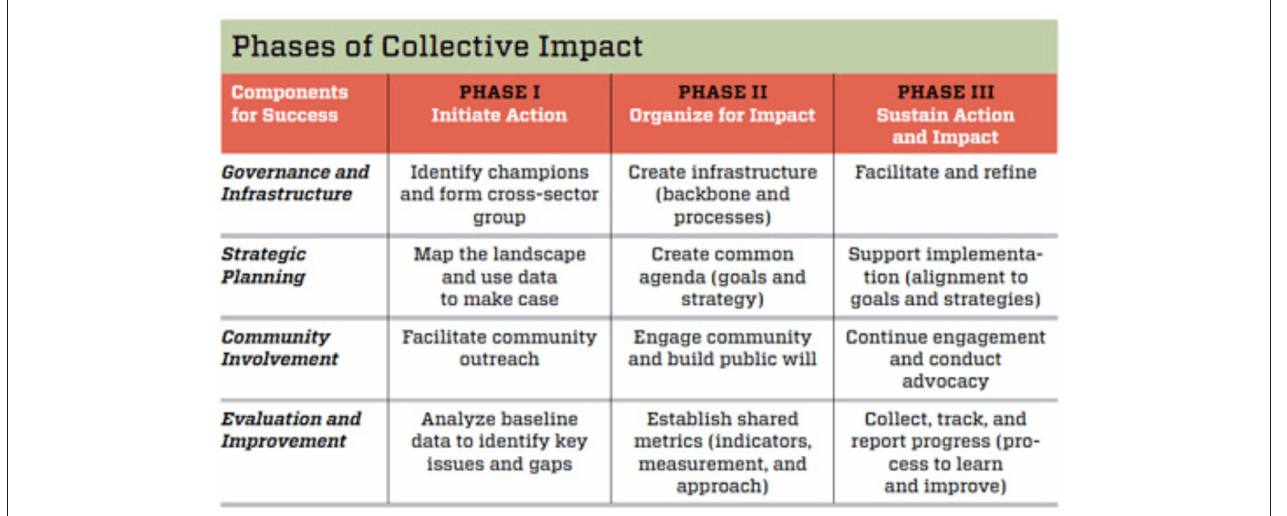
FIGURE 7 | From Hanleybrown et al. (2012), the phases of effort toward developing a collective impact organization.